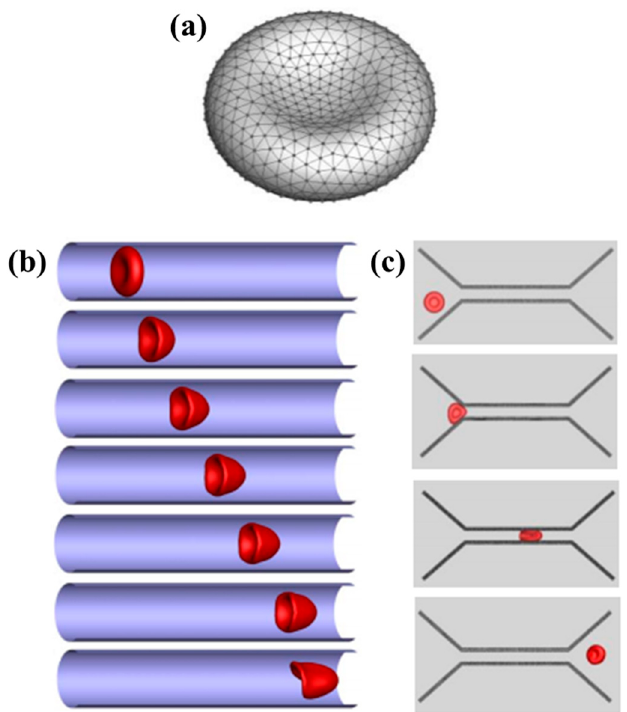
Figure 7. A few examples of past DPD-originated simulations of RBCs. ( a ) A schematic network model for a single RBC for DPD simulation of RBCs deformation [96]. ( b ) DPD simulation of deformation of a single healthy RBC over going through a tube flow [94]. ( c ) Deformation of a single RBC going through a micro channel [96].